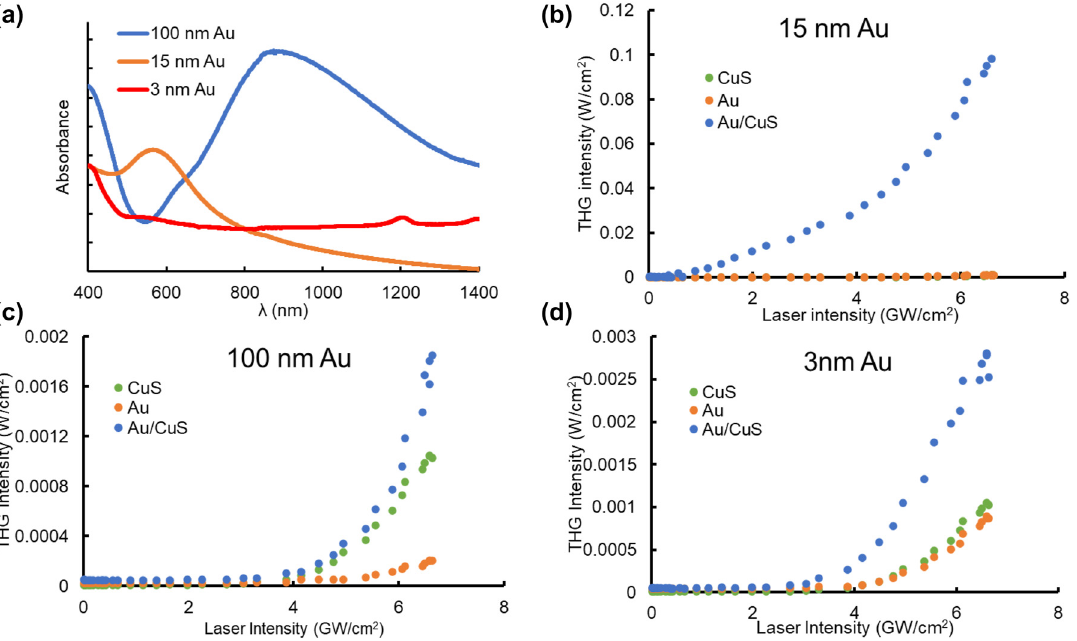
Figure 2: Effects of Au nanoparticle size on THG enhancement due to detuning of harmonic resonance. (a) UV–vis–NIR spectrophotometry of three size Au films deposited on glass microscope slides. Intensity of the THG signal generated by 1050 nm excitation as a function of the input laser intensity for films with different Au nanoparticle diameters and CuS in the transverse orientation, (b) d